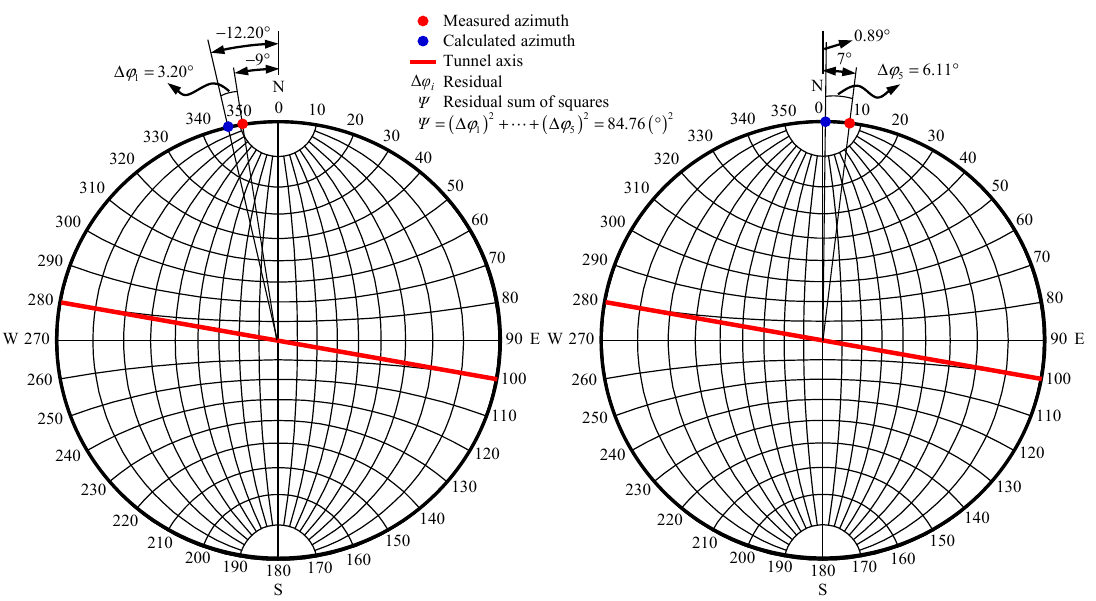
Figure 11. The comparison of in situ stress orientations considering geo-temperature.